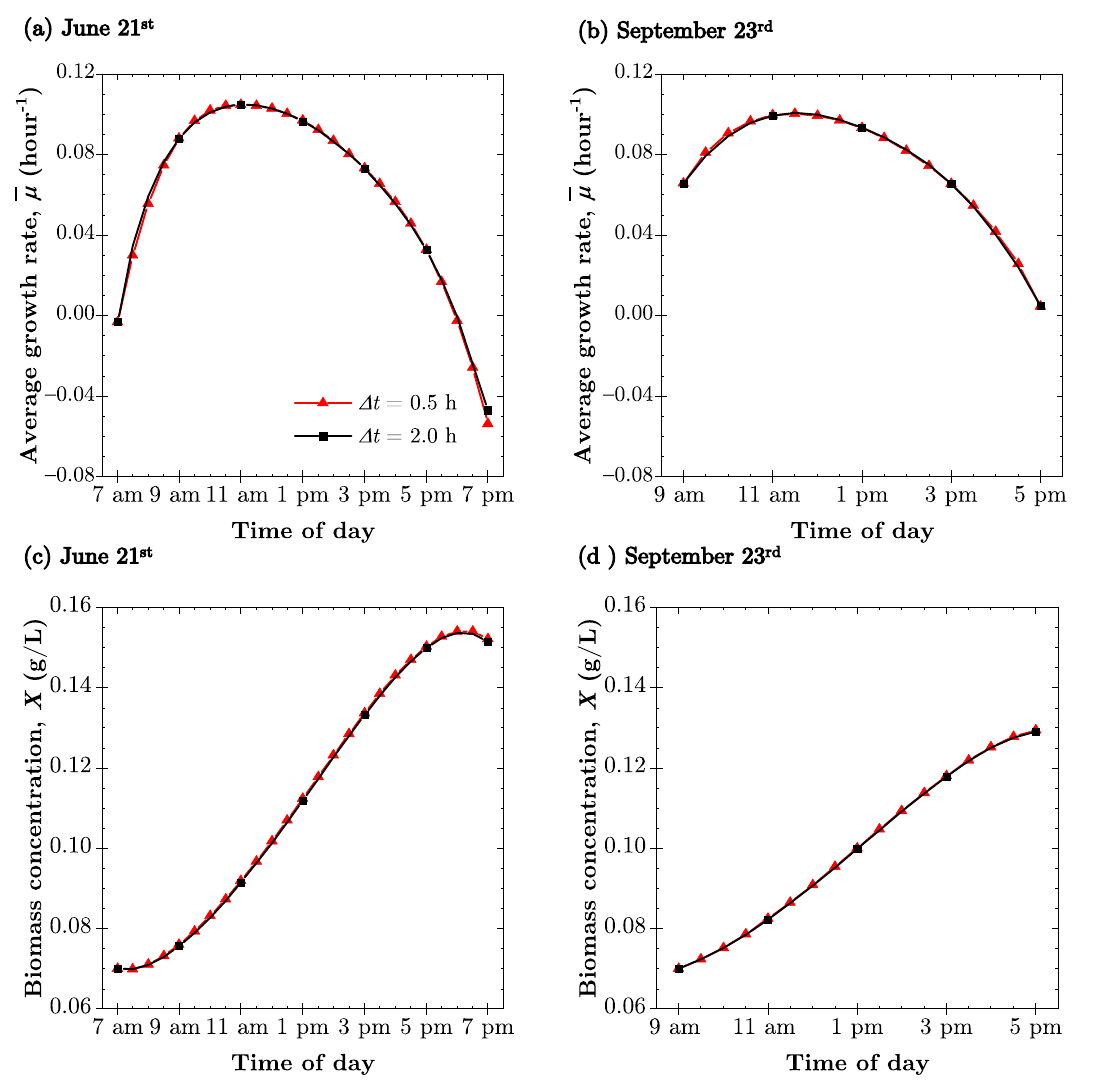
Figure A2. Comparison of the average specific growth rate ¯ µ ( t ) on ( a ) 21 June and ( b ) 23 September and the biomass concentration X ( t ) on ( c ) 21 June and ( d ) 23 September for droplet-free PBRs simulated using a time increment ∆ t of 0.5 h and 2 h. The PBRs had an initial biomass concentration X 0 of 0.07 gL − 1 and a culture depth L of 0.3 m. The maximum relative error in the biomass concentration X ( t ) was 0.1% and 0.3% on 21 June and 23 September,